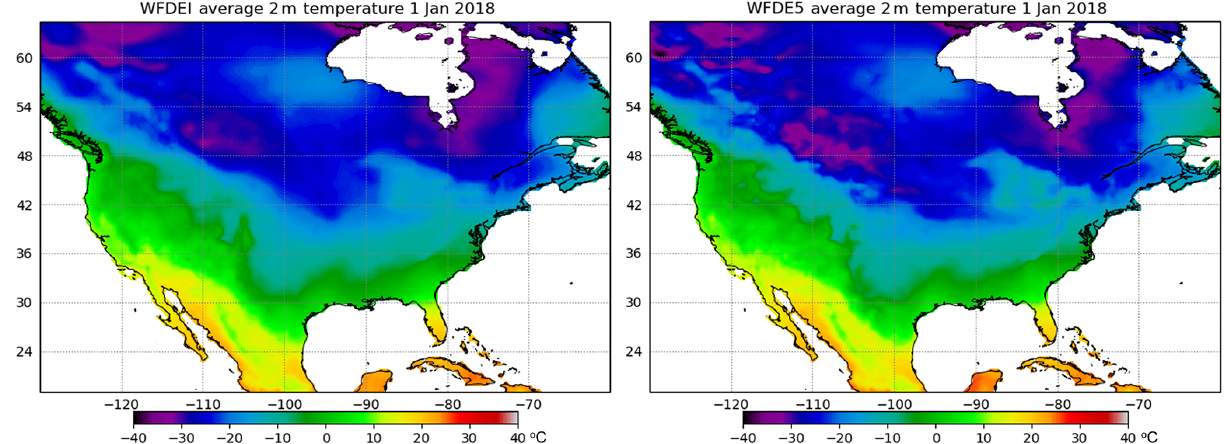
Figure 3. Average 2m temperature on 1 January 2018 for north and central America.